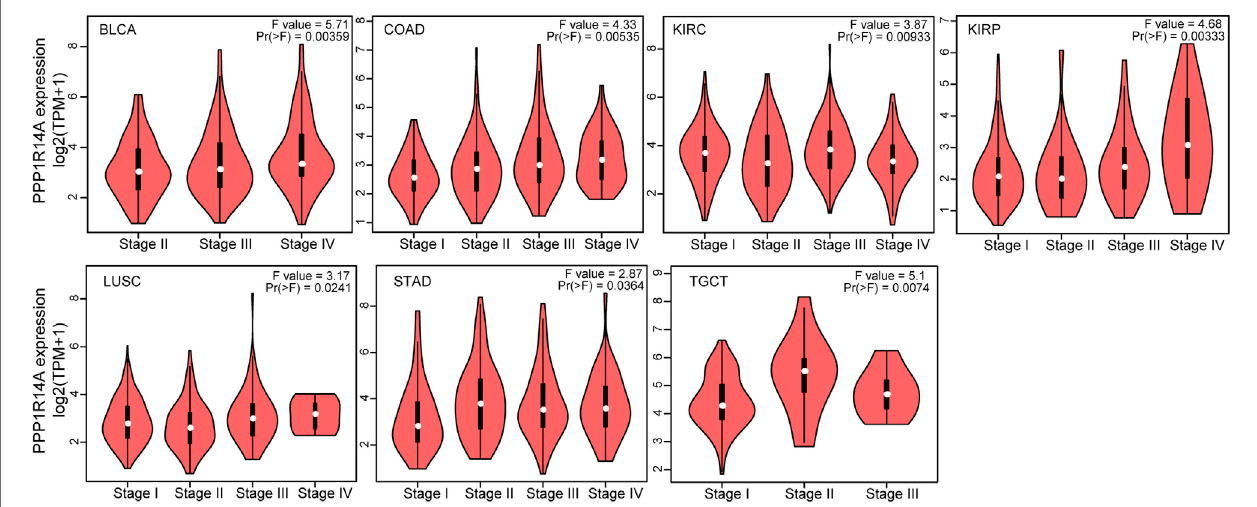
FIGURE 3 | Correlations between the PPP1R14A expression and the main pathological stages, including stage I, stage II, stage III, and stage IV of BLCA, COAD, KIRC, KIRP, LUSC, STAD, and